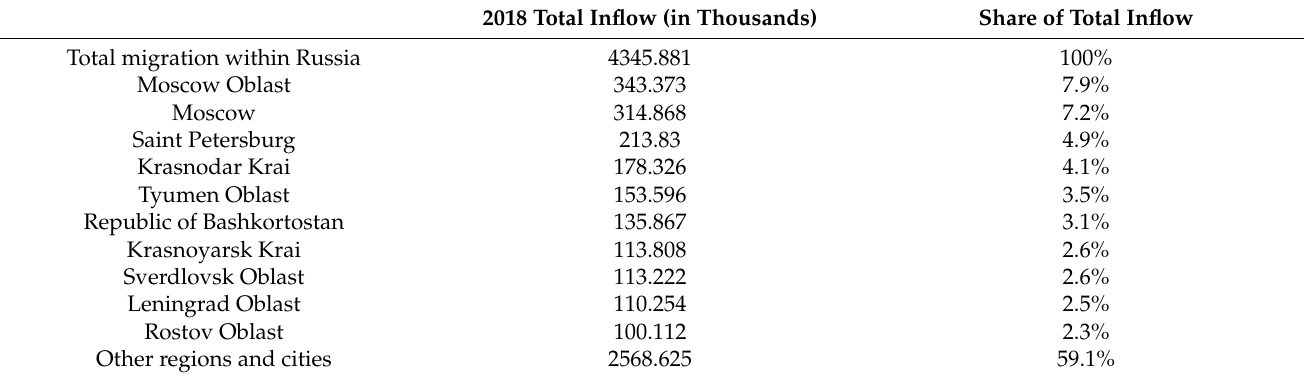
Figure 1. Market shares of Yandex and Google provided by Yandex Radar, StatCounter, and their average. The top 10 regions by total immigration flow in 2018 (see Table 2) represented the starting point that we used to look for online search queries. Table 2. Top 10 Russian regions and cities for migrant inflows in 2018 (Federal State Statistics